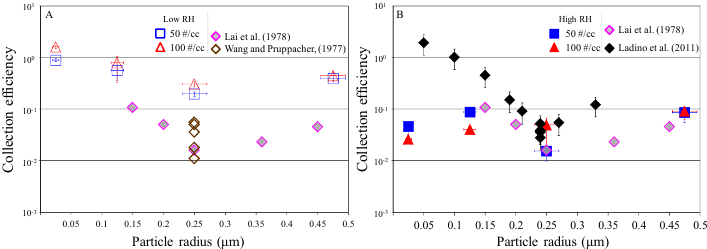
Figure 6. Comparison of CE from this study to previous experimental work. (a) Low-RH experiments. (b) High-RH experiments. Shapes (squares and triangles) represent different aerosol concentrations. Diamond shapes represent previous experimental work. Black diamonds are from Ladino et al. (2011), with RH 88 ± 2%, aerosol concentration 2000cm − 3 and droplet size of 12.8–20.0µm. Brown diamonds are from Wang and Pruppacher (1977), with RH of 23 ± 2%, aerosol concentration of about 10 17 cm − 3 and droplet size of 170–340µm. Pink diamonds are from Lai et al. (1978), with 620µm droplets and no information regarding the RH or aerosol concentration.